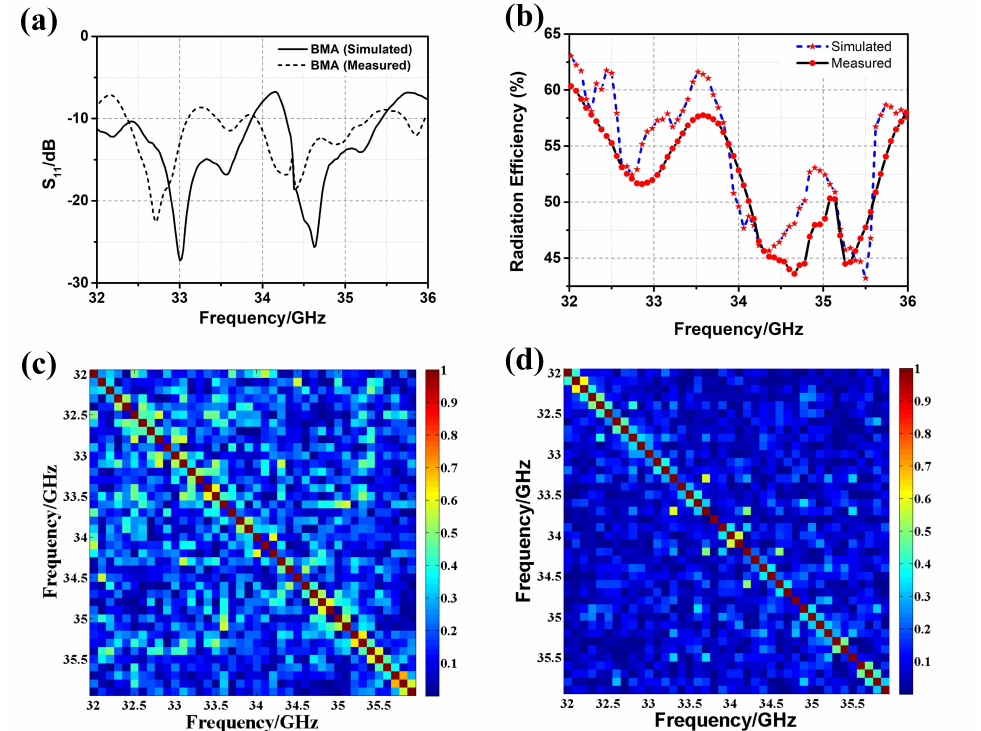
Figure 6. ( a ) S 11 of the BMA with/without metalens, both simulated and measured; ( b ) radiation efficiency of the BMA, both simulated and measured; ( c ) correlation coefficients of the simulated frequency-diverse radiation patterns; ( d ) orcrelation coefficients of the measured frequency-diverse radiation